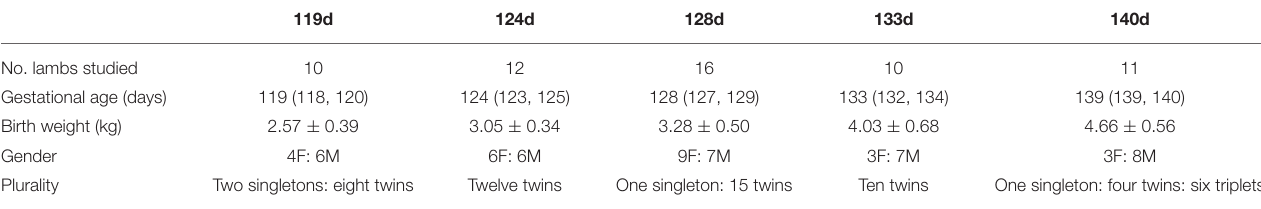
TABLE 2 | Birth characteristics of the Study 2 comparison